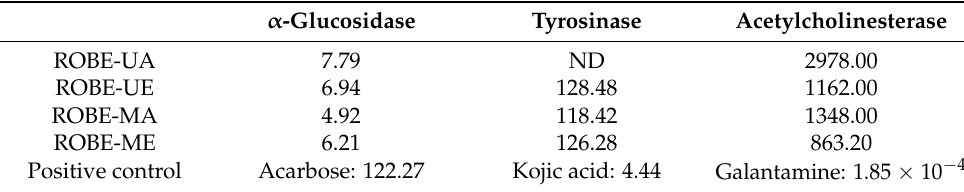
Table 5. Enzyme inhibitory activity of ROBE samples (IC 50 in µ g/mL).